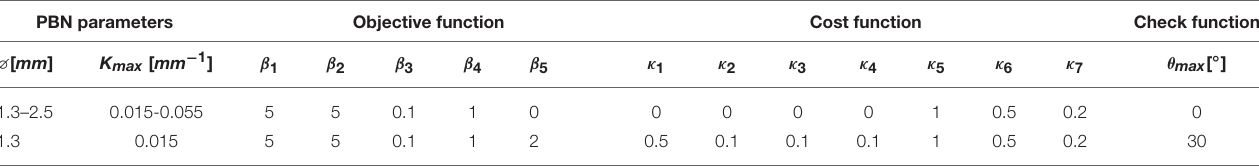
TABLE 2 | Parameters used in the experimental setup. PBN parameters Objective function Cost function Check